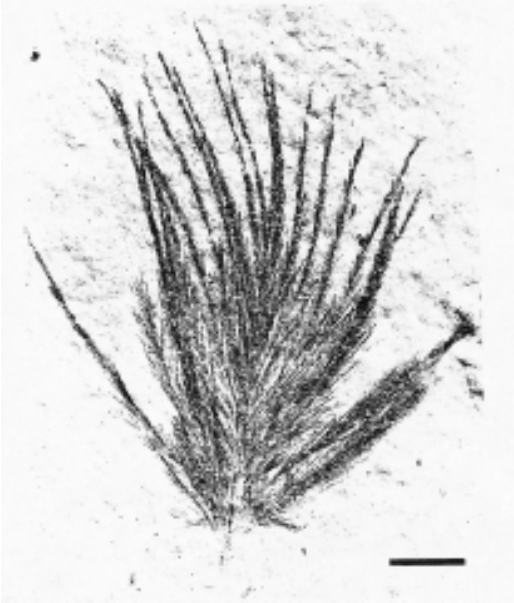
Fig. 17 – Down feather found in the Crato Member (Aptian), Santana Formation, Araripe Basin. Scale bar: